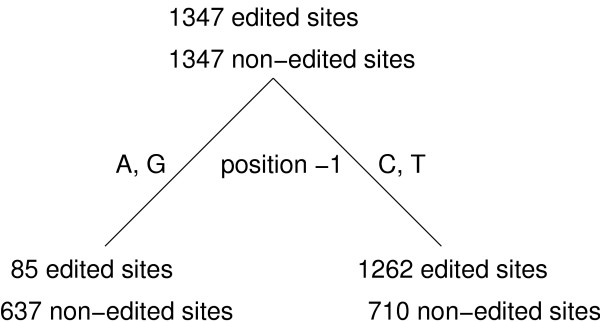
Cross-validated pruned classification tree for the combined dataset. The number of edited and non-edited sites are given at each node. The single split is based on the nucleotides at position -1 relative to the edited site.